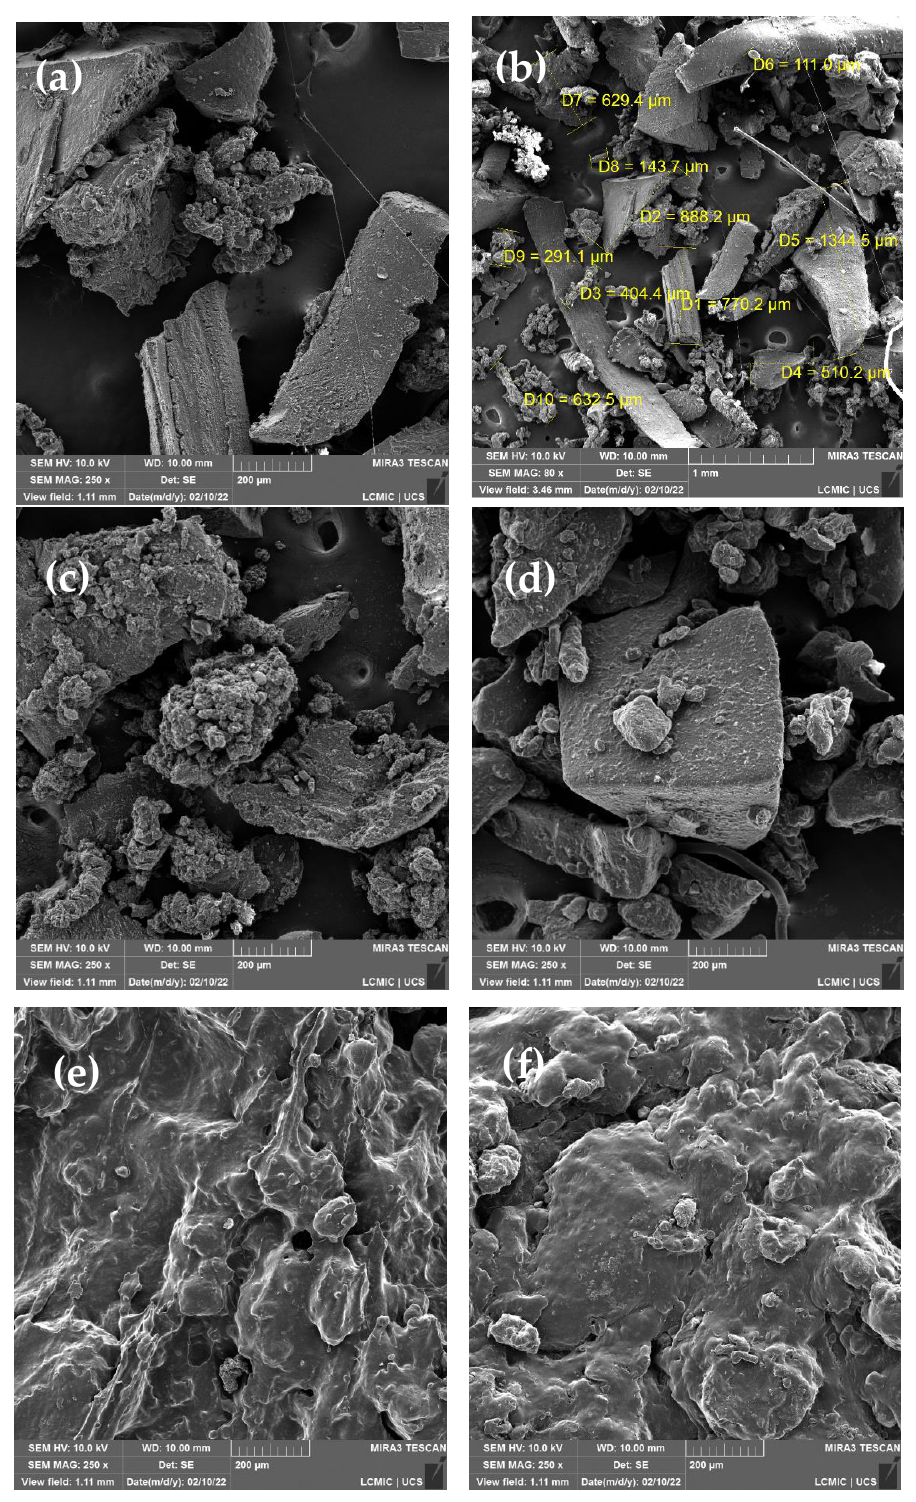
Figure 6. SEM micrographs for GTR: before mechanical treatment ( a , b ); after treatment at 3 min. ( c ) and 60 min. ( d ) in n 1 ; 6 min. ( e ) and 10 min. ( f ) in n 2 .